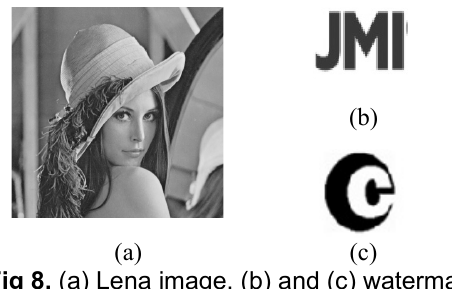
Fig 8. (a) Lena image, (b) and (c) watermark